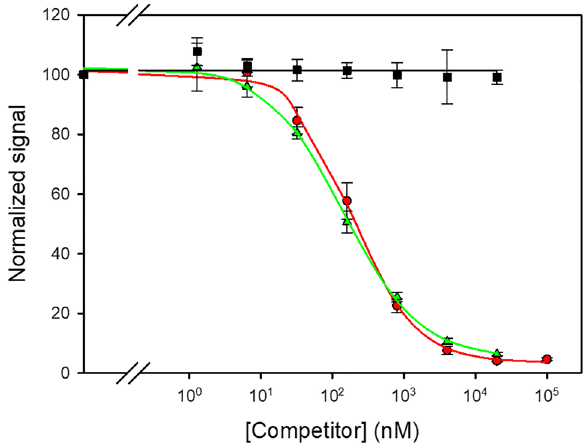
Figure 6. Inhibition curves with the antiserum that was derived from conjugate BSA- V4 . Assay conditions: ELISA plates were coated with conjugate OVA ‒ V4 (1 µg/mL), and the antibody was assayed at a 1/3,000 dilution. Competitors were patulin (squares), purified adduct V (circles), or a mixture between patulin and the sodium salt of 4-bromothiophenol